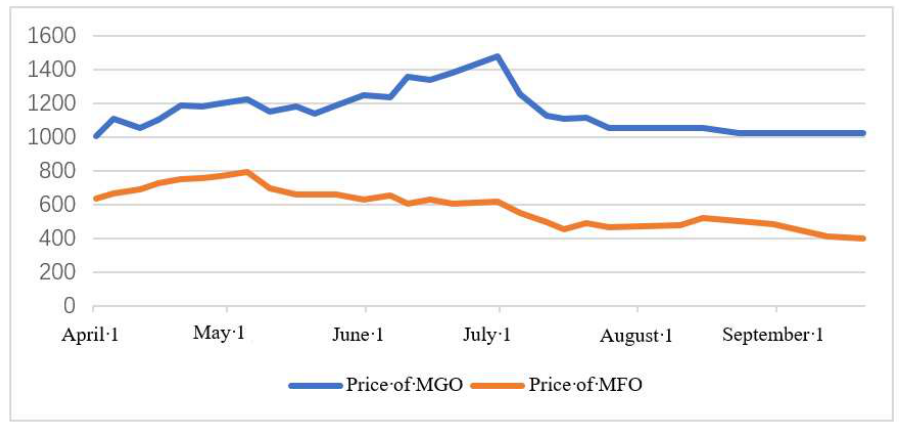
Figure 2. Prices of MFO and MGO in Singapore Port in 2022.